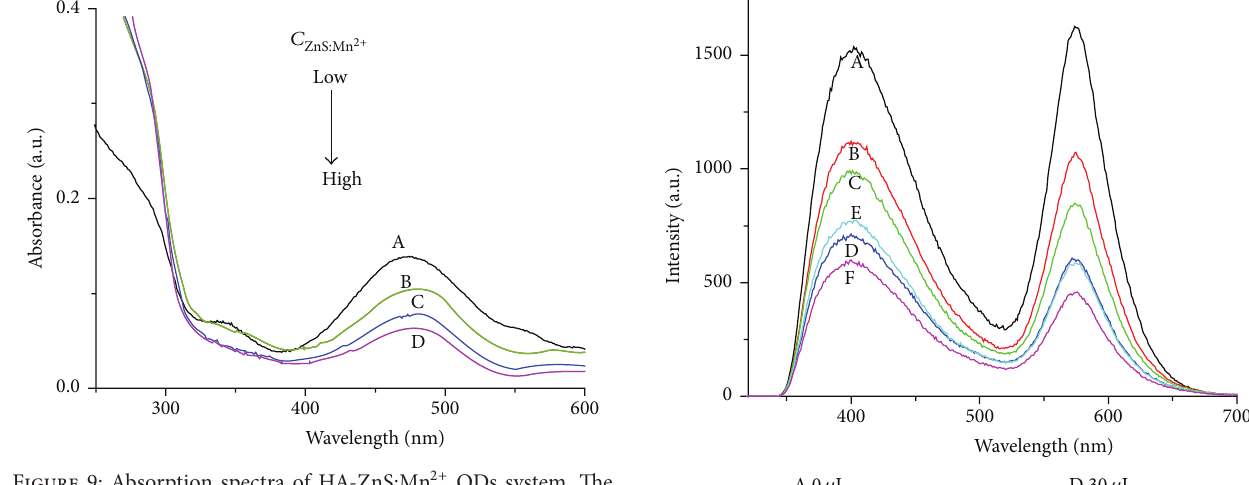
Figure 9: Absorption spectra of HA-ZnS:Mn 2+ QDs system. The HA concentration was fixed at 1.8315 × 10 −4 M and the concentration of ZnS:Mn 2+ QDs (8.0143 × 10 −3 M) increased from top to bottom. ZnS:Mn 2+ QDs as a good candidate for the purpose of pho-